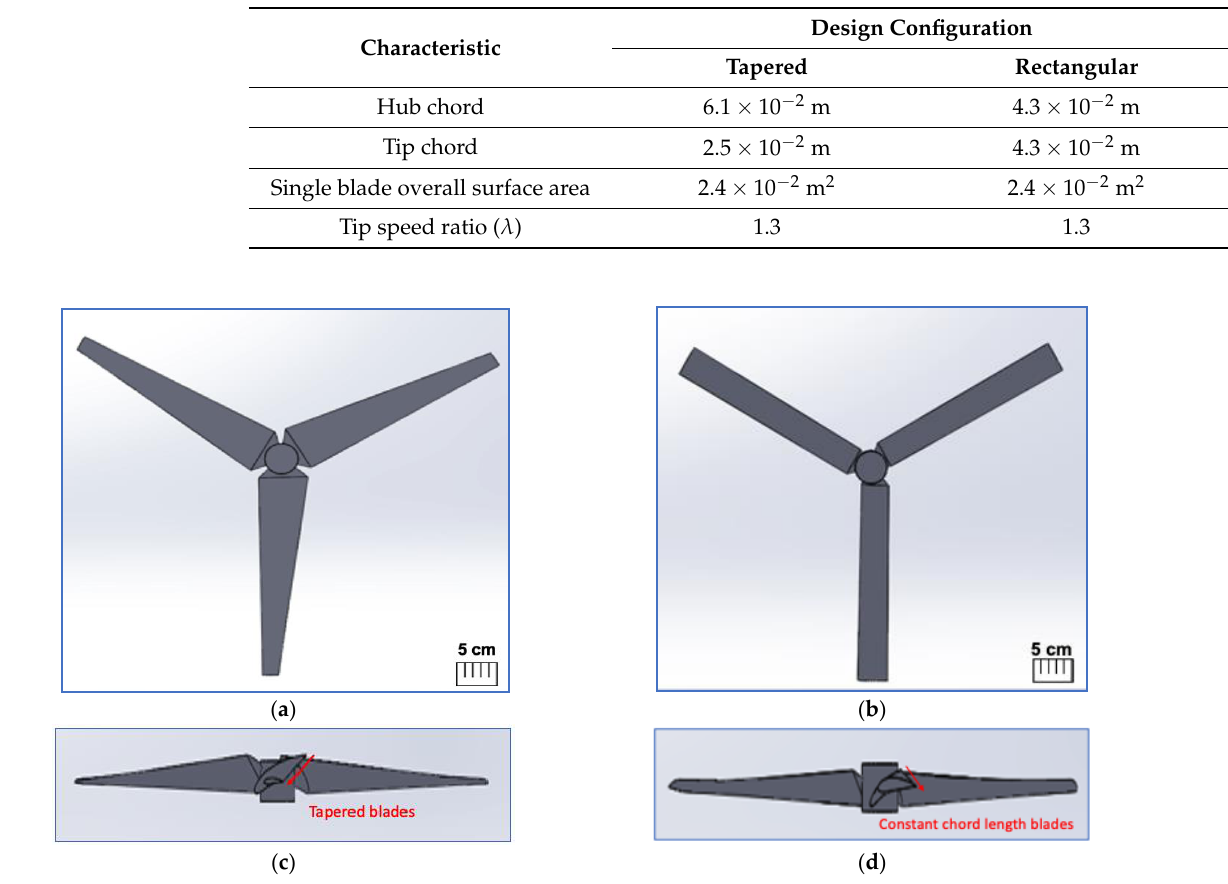
Figure 1. SSWT CAD designs with ( a , c ) tapered and ( b , d ) rectangular configurations for the NACA4412 airfoil, with x-z view ( top ) and y-x view ( bottom Table 1. SSWT design characteristics.